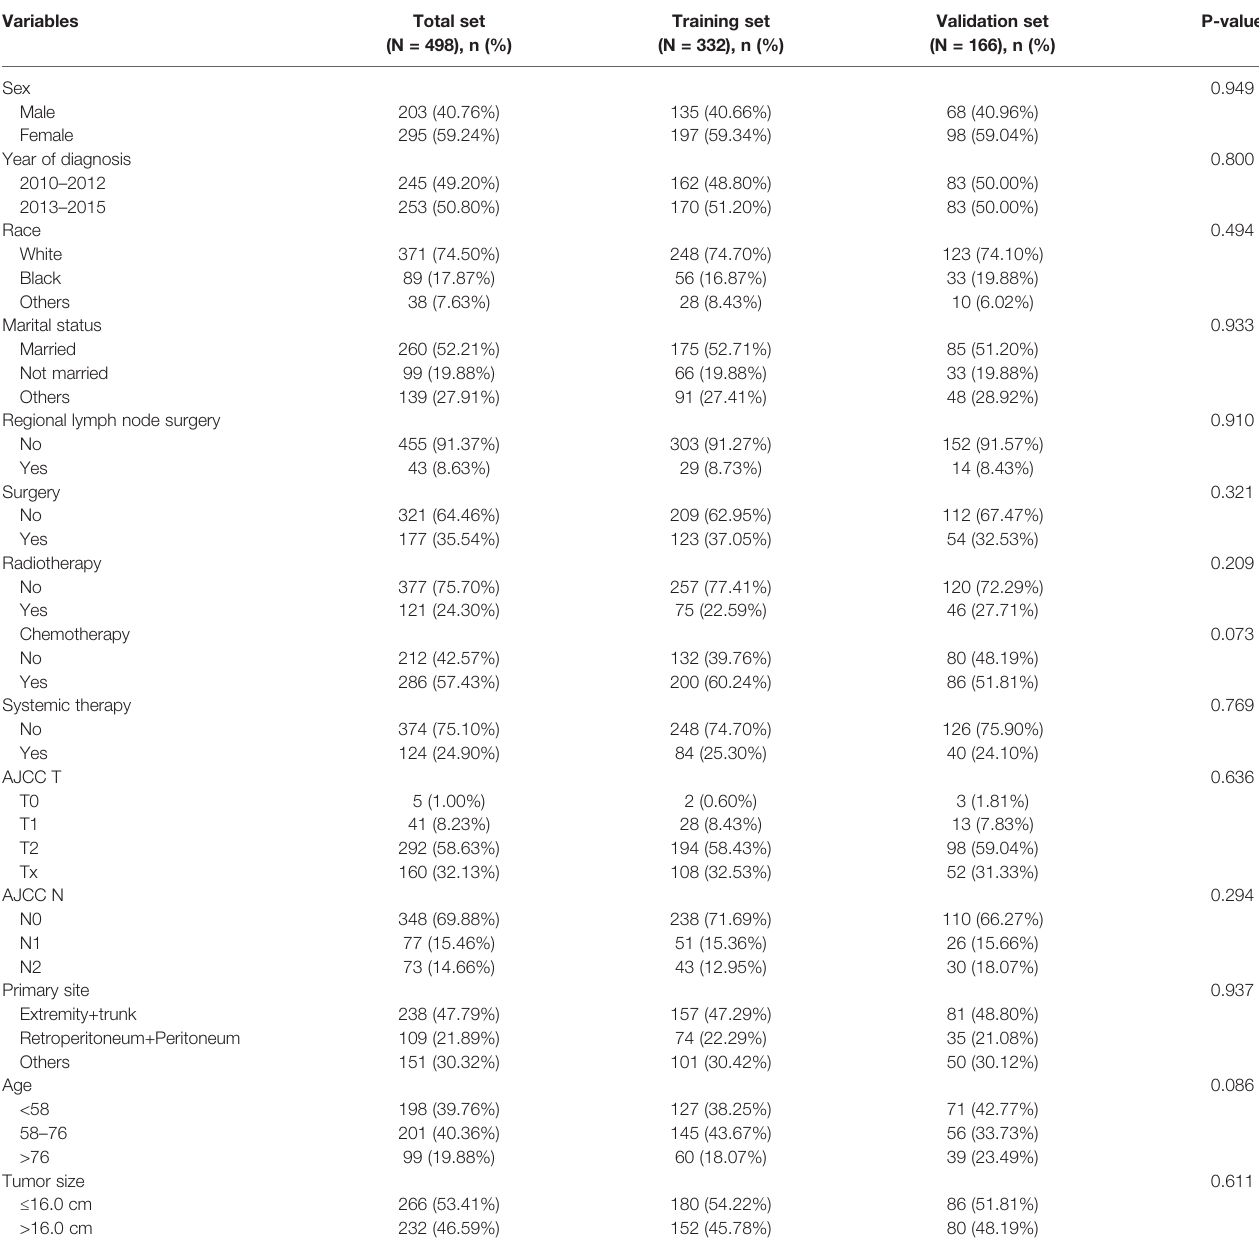
TABLE 1 | Baseline demographic and clinicopathological characteristics of LMS patients with metastasis in the whole dataset, training dataset, and validation